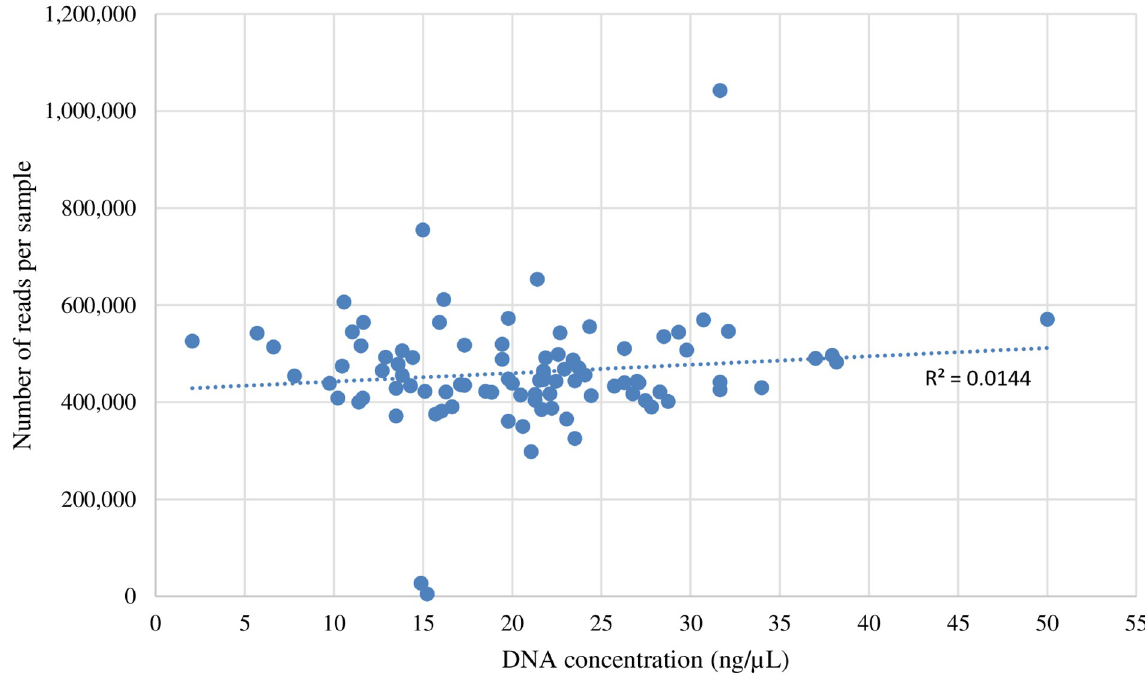
Fig 1. DNA concentrations vs reads per sample. Number of reads generated per sample (Y axis) from sample DNA concentrations in ng/ μ L (X axis).